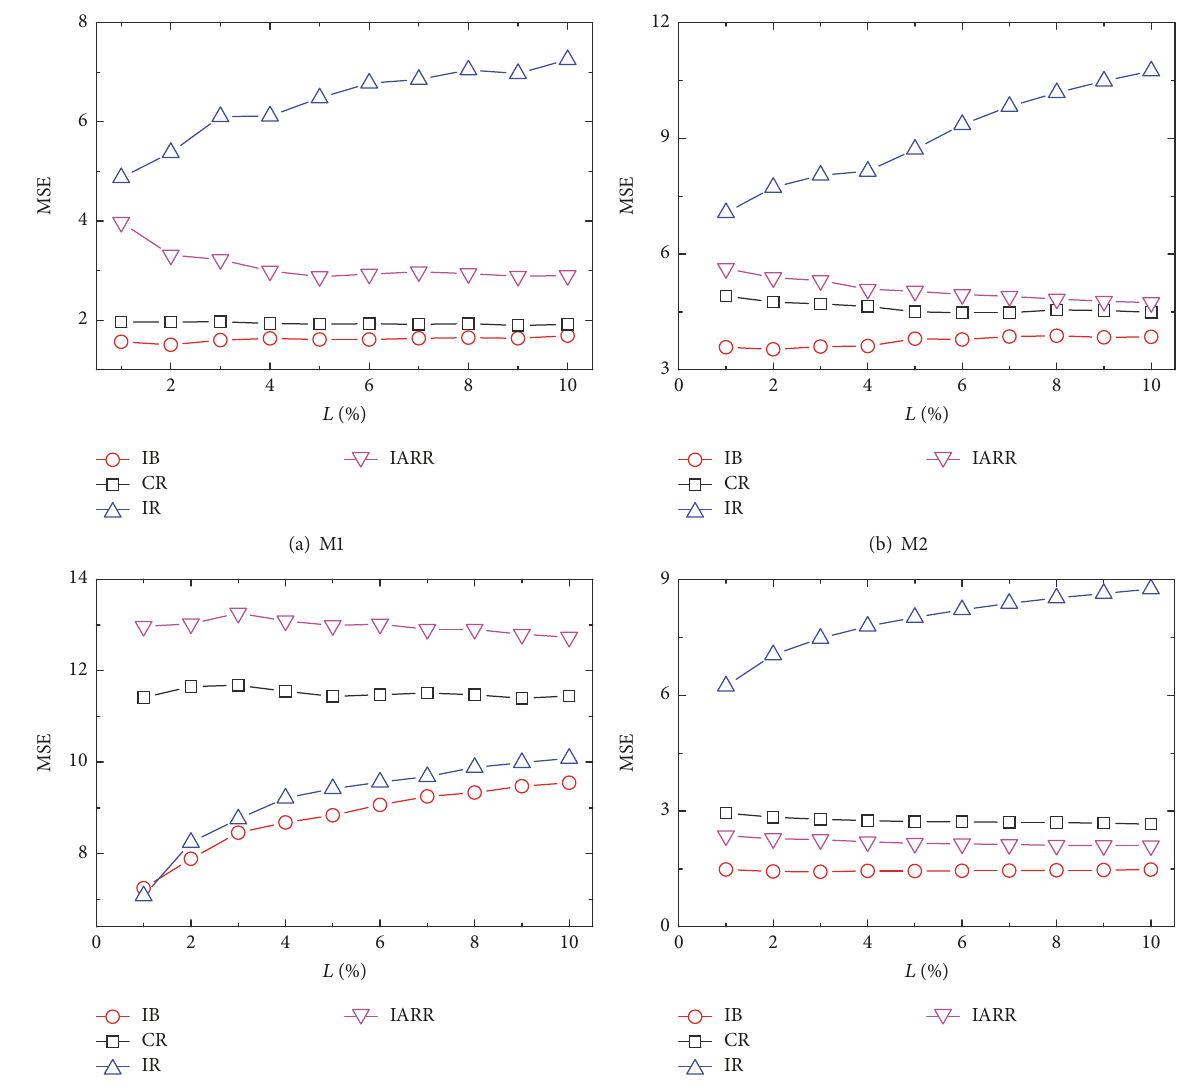
Figure 3: Accuracy of algorithms for quantifying users’ reputation measured by MSE. 𝐿 equals the percentage [1 % , 10 % ] of |𝑈| . The four methods are IB, CR, IR, and